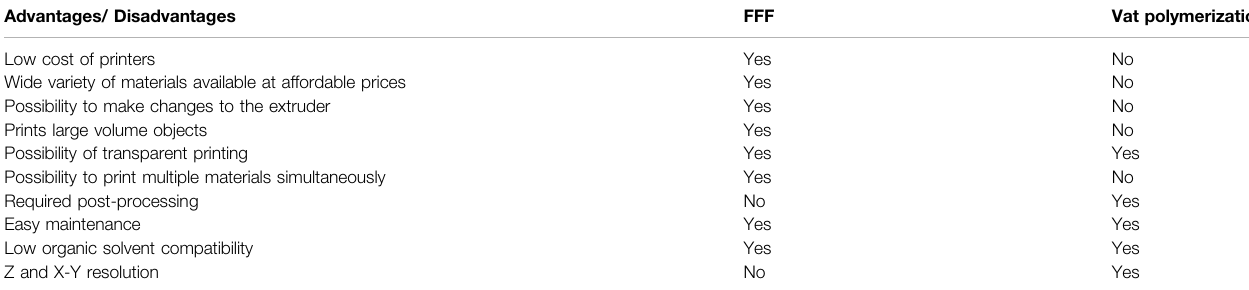
TABLE 1 | Advantages and disadvantages of the FFF and VP 3D